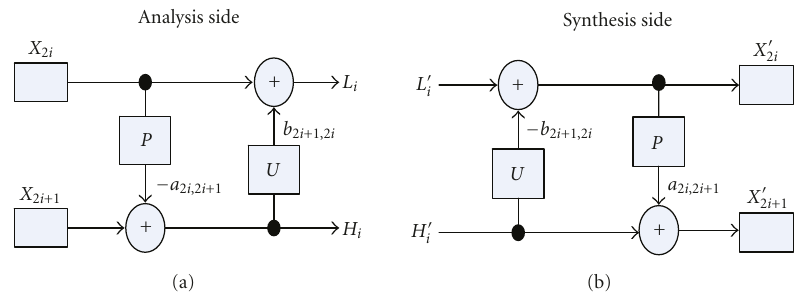
Figure 2: The first level decomposition of DCWL Haar type.